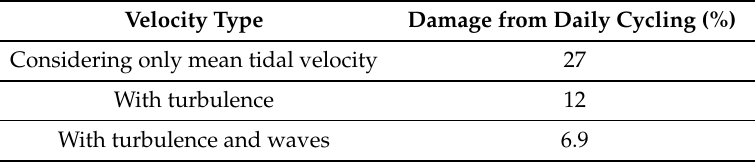
Table 10. Lifetime